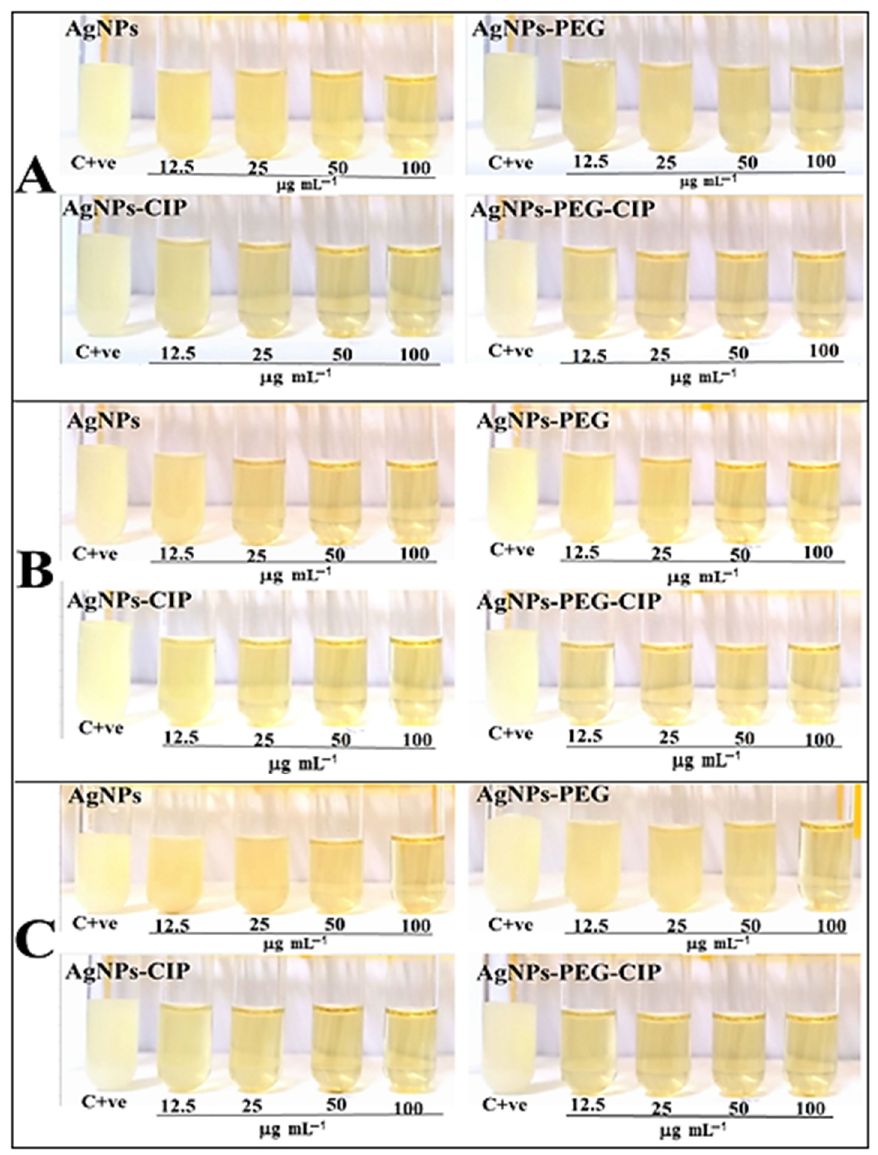
Figure 15. Minimum inhibitory concentrations (MIC) and minimum bactericidal concentrations (MBC) of the AgNPs and their conjugates against pathogenic bacteria: ( A ) S. aureus , ( B ) A. baumannii , and ( C ) S. marcescens.